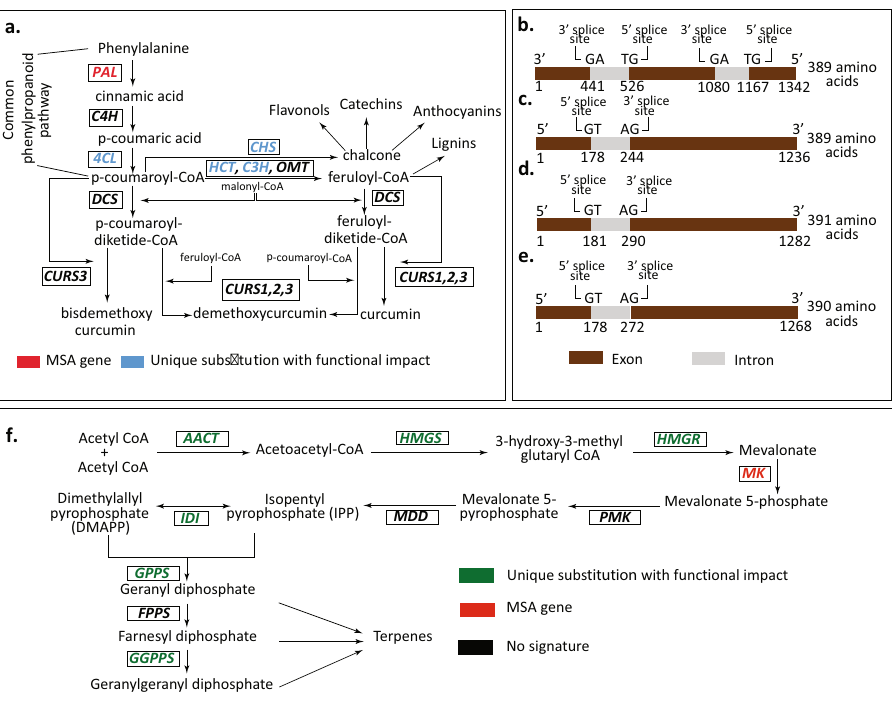
Fig. 3 Pathways and genes involved in secondary metabolism of C. longa . a Curcuminoid biosynthesis pathway in C. longa 75,76,79 . PAL = phenylalanine ammonia lyase, C4H = cinnamate-4-hydroxylase, 4CL = 4-coumarate-CoA ligase, HCT = hydroxycinnamoyl transferase, C3H = cinnamate-3-hydroxylase, OMT = O-methyltransferase, CHS = chalcone synthase, DCS = diketide-CoA synthase, CURS1 = curcumin synthase 1, CURS2 = curcumin synthase 2, CURS3 = curcumin synthase 3. b Structure of DCS gene. c Structure of CURS1 gene. d Structure of CURS2 gene. e Structure of CURS3 gene. f Evolutionary signatures in mevalonate pathway of terpenoid biosynthesis 80 . AACT = acetoacetyl-CoA thiolase, HMGS = HMG-CoA synthase, HMGR = HMG-CoA reductase, MK = mevalonate kinase, PMK = phosphomevalonate kinase, MDD = mevalonate-5-diphosphate decarboxylase, IDI = isopentenyl diphosphate isomerase, GPPS = geranyl diphosphate synthase, FPPS = farnesyl diphosphate synthase, GGPPS = geranylgeranyl diphosphate